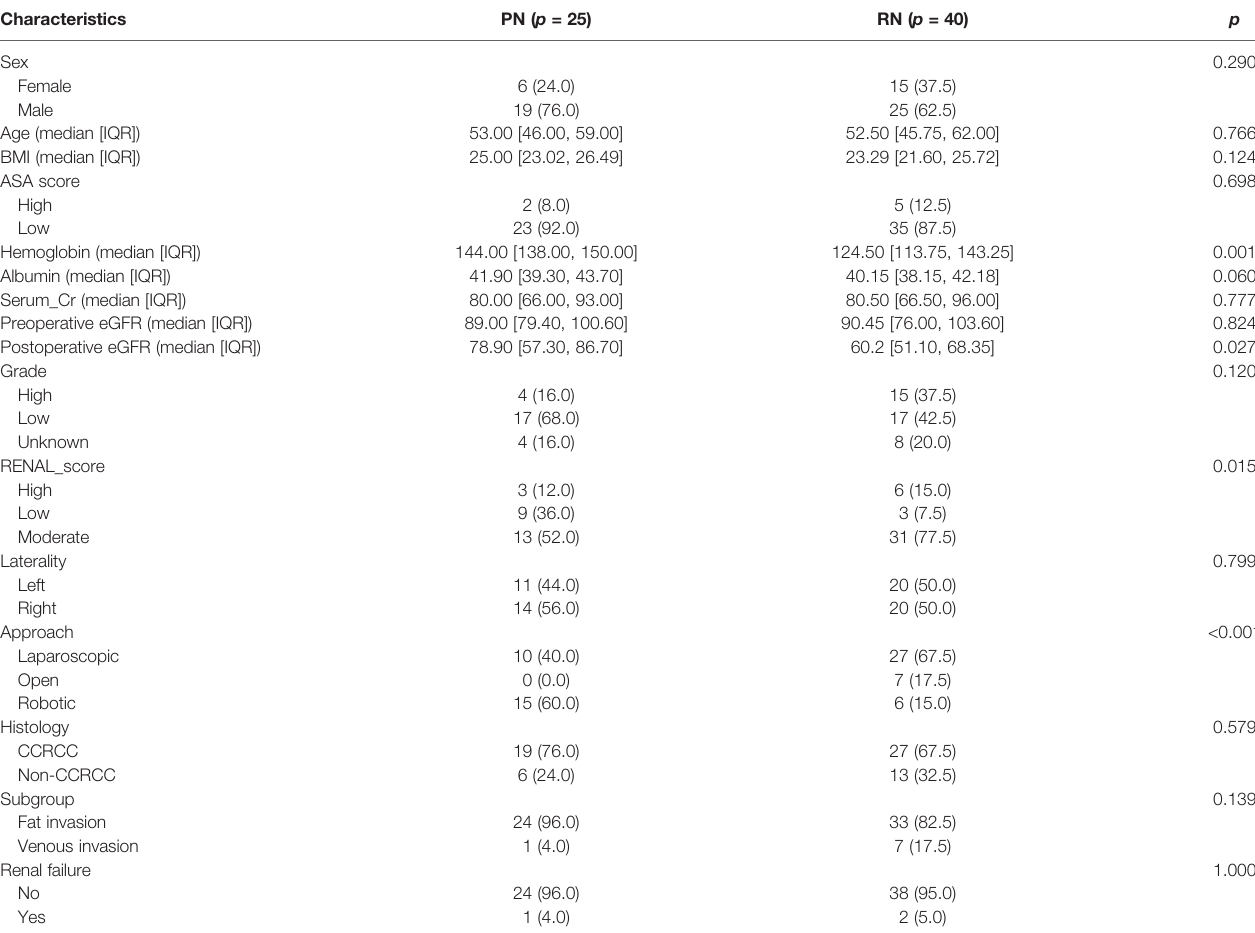
TABLE 9 | Characteristics of PN and RN groups in TJH cohorts. Characteristics